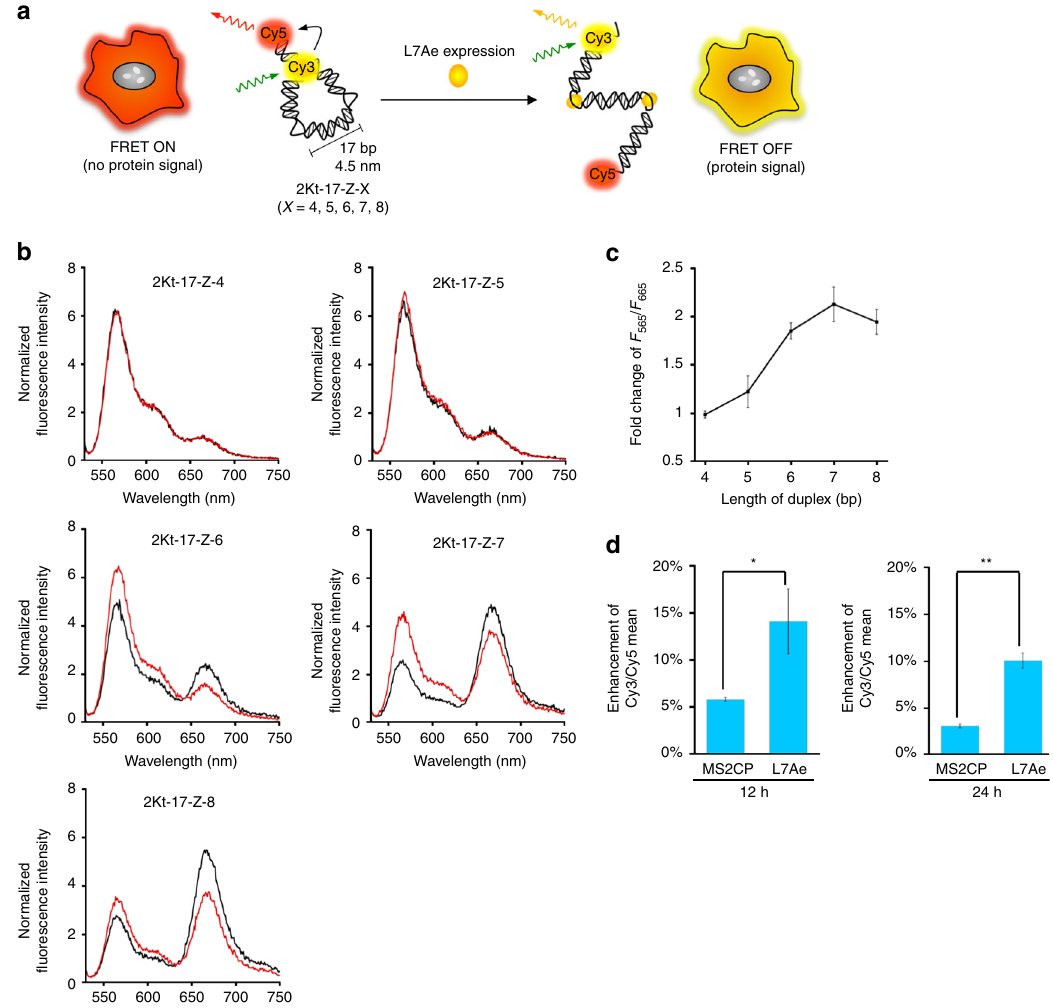
Fig. 3 Actuation of protein-driven RNA nanodevice in vitro and inside live mammalian cells. a Schematic illustration of an intracellular RNA nanodevice that produces a change in the FRET signal upon detecting protein signals inside live mammalian cells. The in silico predicted lengths of each side of 2Kt-17-Z-X were ~4.5 nm. b Fluorescence spectra of 2Kt-17-Z-X ( X = 4, 5, 6, 7, 8) in the absence ( black ) and presence ( red ) of L7Ae in vitro. c Plots of fold change in F 565 / F 665 , [ F 565 / F 665 (+ L7Ae)]/ [ F 565 / F 665 ( − L7Ae)] versus the length of the RNA duplex. d Flow cytometric analysis of the actuation of the RNA nanodevice by a speci fi c L7Ae-K-turn interaction within cells. MS2CP- or L7Ae-coding modRNA (500 ng) and 2Kt-17-Z-7 or 2dKt-17-Z-7 RNA nanodevices (8 pmol) were co-transfected into HeLa cells. Enhancement of the Cy3/Cy5 mean after 12 ( left ) and 24 ( right ) hours transfection was calculated from the Cy3/Cy5 mean intensities of cells transfected with 2Kt-17-Z-7 normalized to the Cy3/Cy5 mean intensity of cells transfected with 2dKt-17-Z-7. The data are presented as the mean ± SD ( n = 3). * P < 0.05, ** P < 0.01 (Welch ’ s t Fig. 3a and Supplementary Fig. 17) and measured the fl uorescence spectra of the RNA variants labelled with Cy3 and Cy5 in the presence and absence of L7Ae (Fig. 3b). The fl uorescence spectra of 2Kt-17-Z-4 and 2Kt-17-Z-5 showed few changes in the presence of L7Ae. In contrast, for 2Kt-17-Z-6, 2Kt-17-Z-7 and 2Kt-17-Z-8, F 565 increased and F 665 decreased simultaneously due to the RNP formation. We found the highest fold change in the F 565 / F 665 values before and after the RNP formation when employing 2Kt-17-Z-7 (Fig. 3c). To check size effects of the RNA nanostructures, we also constructed larger Z-shape nanostructures, 2Kt-28-Z, with short RNA duplexes (from 5 to 7 bp) and con fi rmed that changes in the fl uorescence